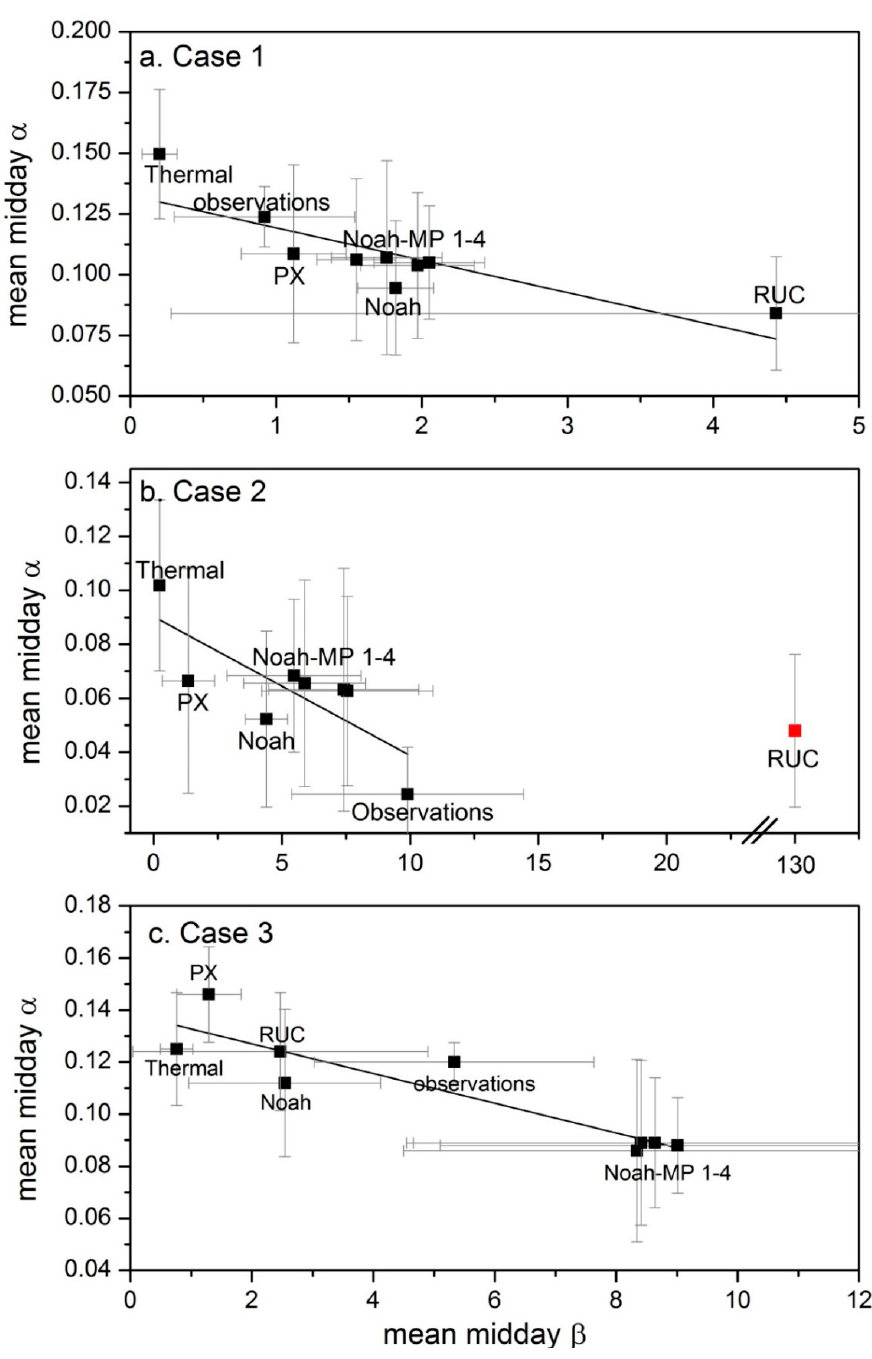
Figure 10. Scatter plot of mean (± standard deviation) midday values of Bowen ratio and wind shear exponent for each LSM and the observations for ( a ) Case 1 (June 2011); ( b ) Case 2 (July 2011) and ( c ) Case 3 (November–December 2012). The data are fitted with a linear regression model (Case 1 slope = −0.013, R 2 = 0.66; Case 2 slope = −0.005, R 2 = 0.55; Case 3 slope = −0.006, R 2 = 0.82). Models which simulated higher Bowen ratios (sensible heat > latent heat) tended to simulate less wind